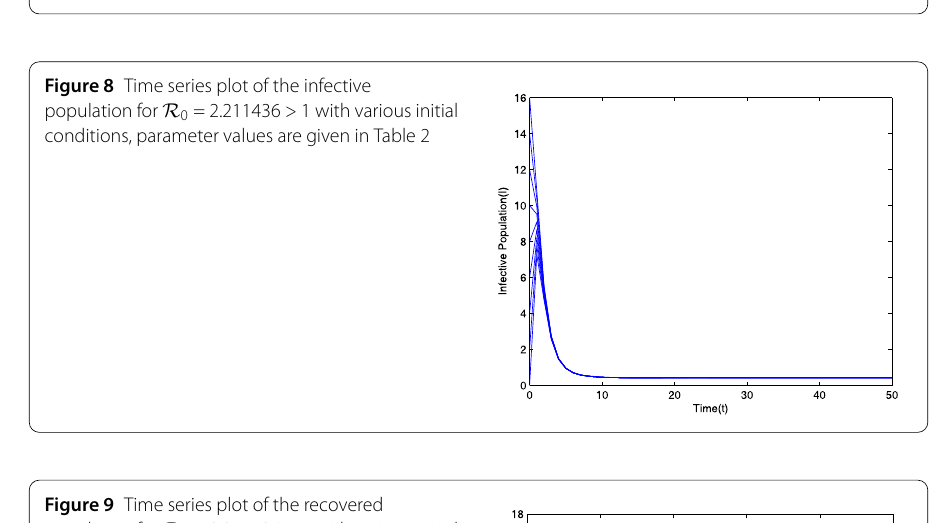
Figure 9 Time series plot of the recovered population for R 0 = 2.211436 > 1 with various initial conditions, parameter values are given in Table 2